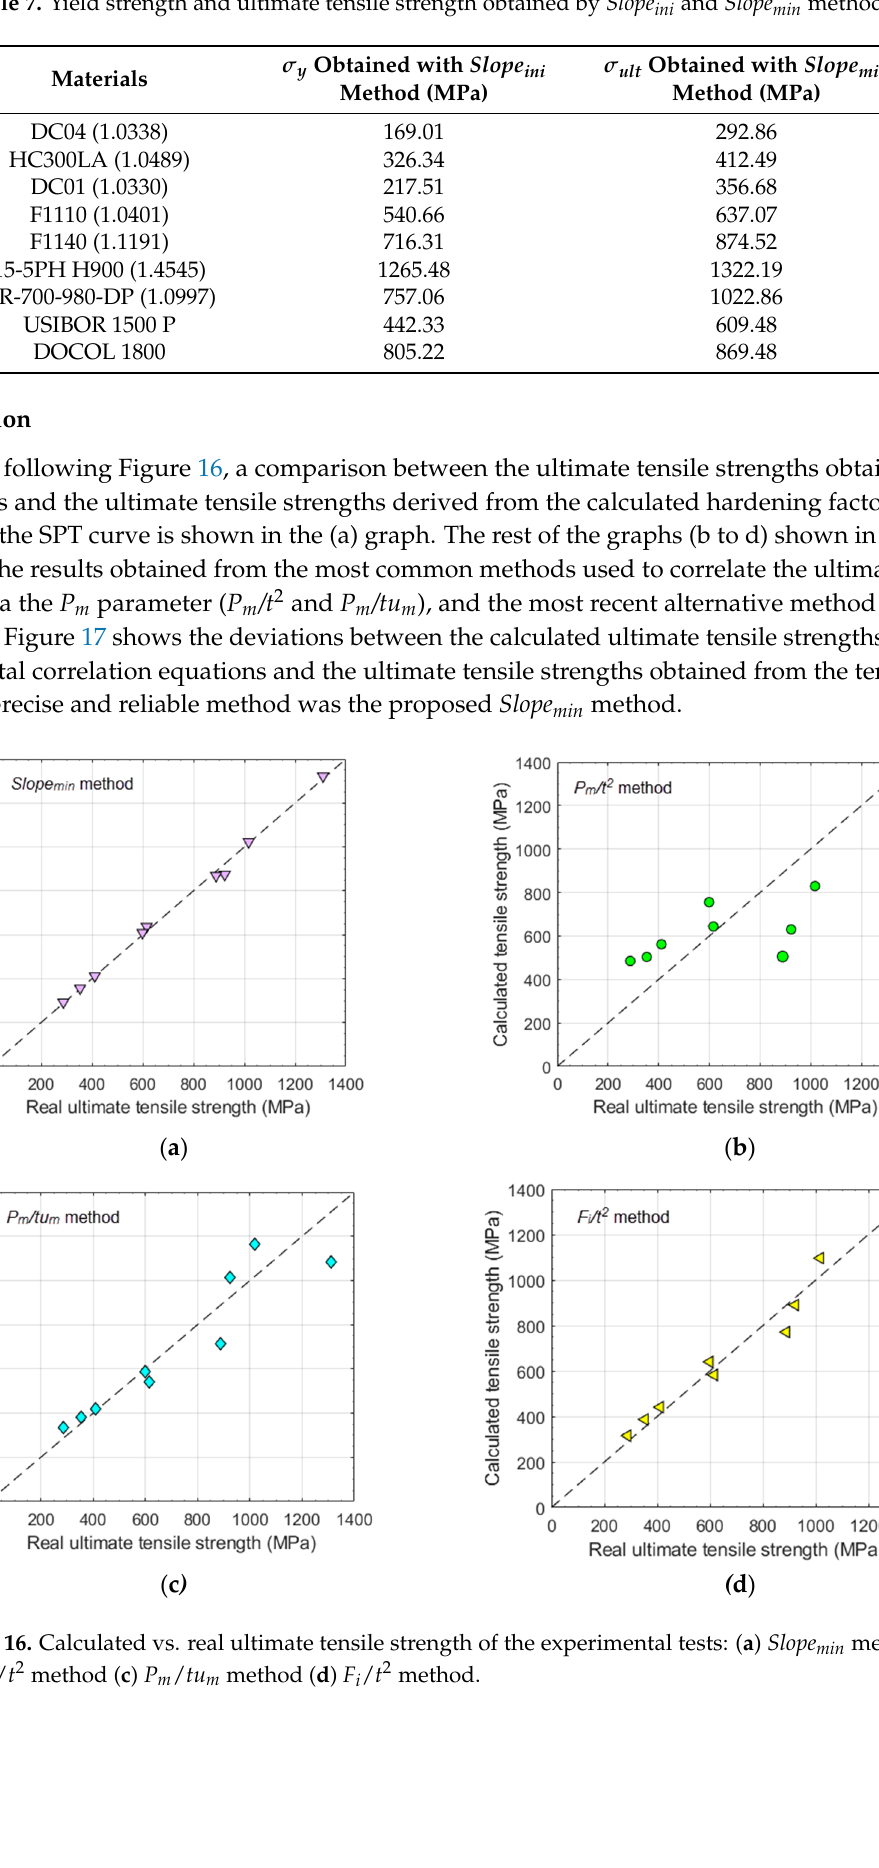
Table 7. Yield strength and ultimate tensile strength obtained by Slope ini and Slope min methods.